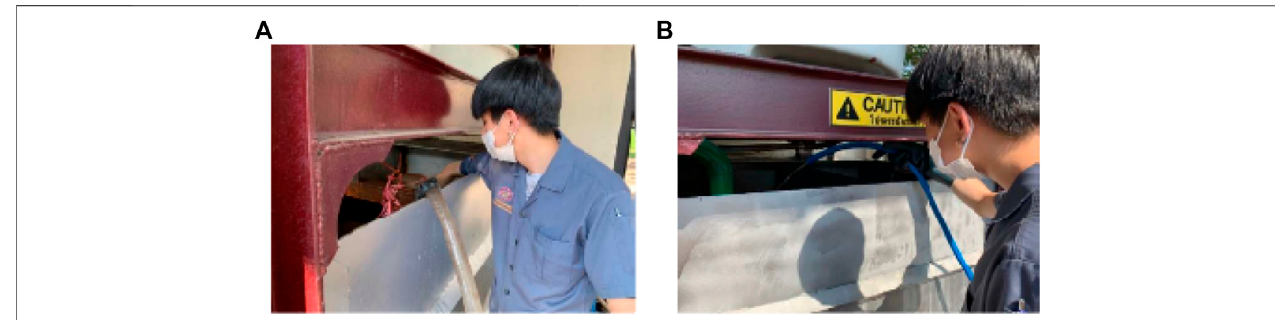
Frontiers in Energy Research |